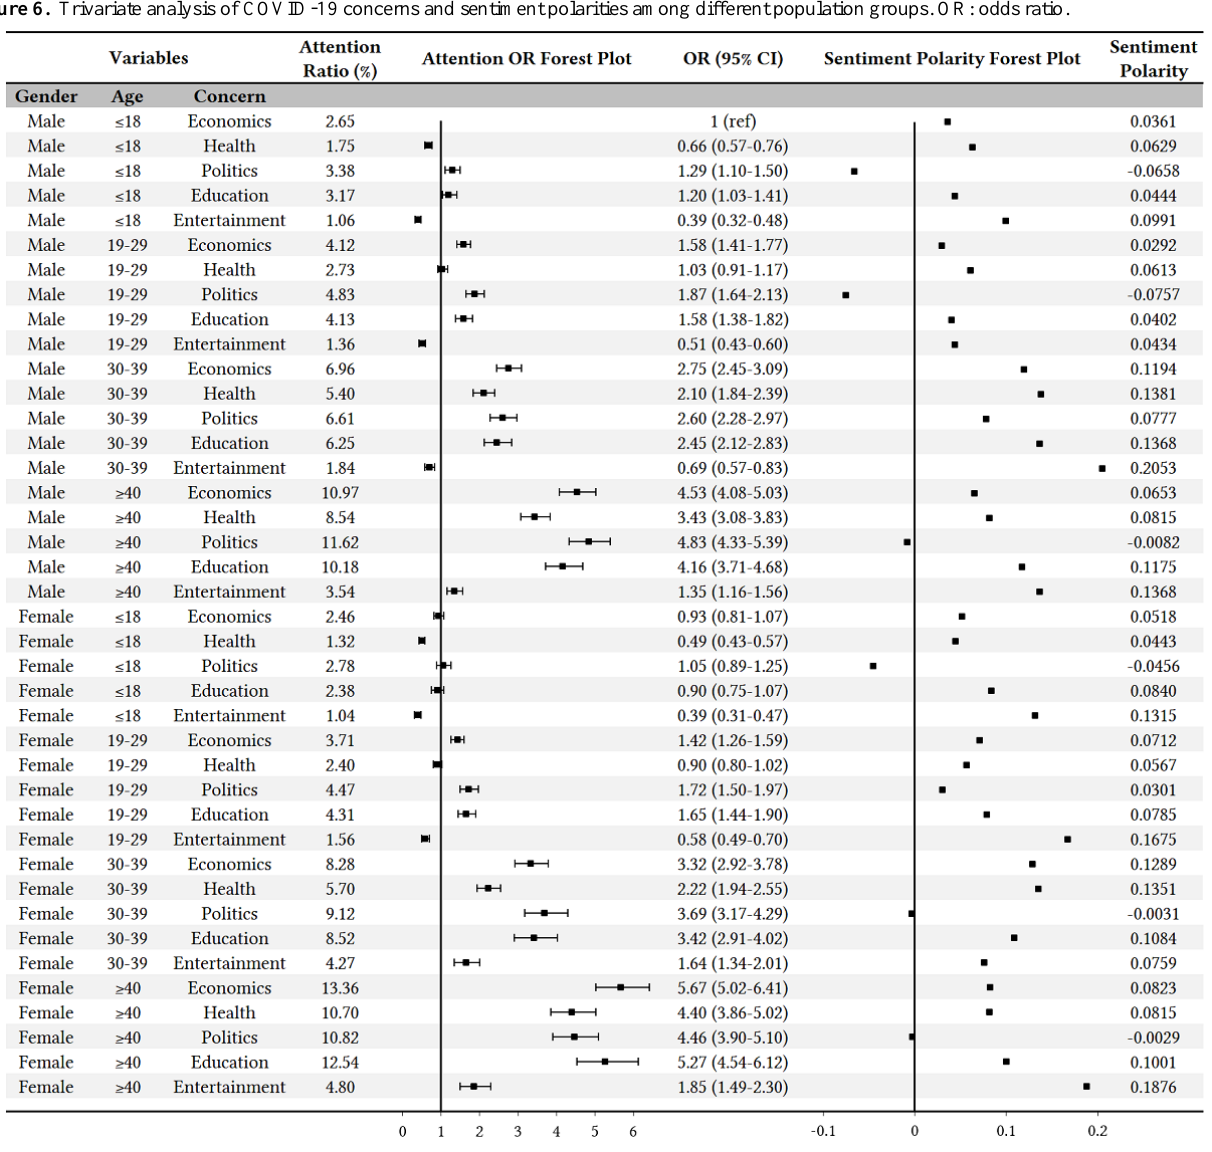
Figure 6. Trivariate analysis of COVID-19 concerns and sentiment polarities among different population groups. OR: odds